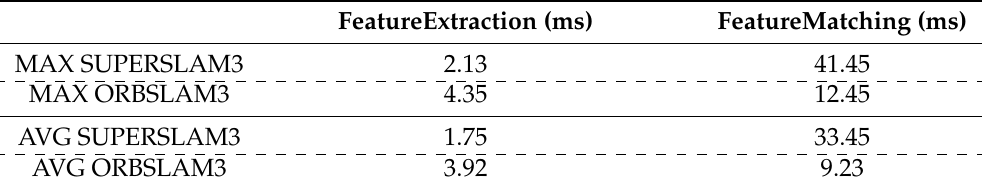
Table 6. Time statistics: comparison of maximum and average time performance for feature extraction and descriptors matching in ORBSLAM3 and